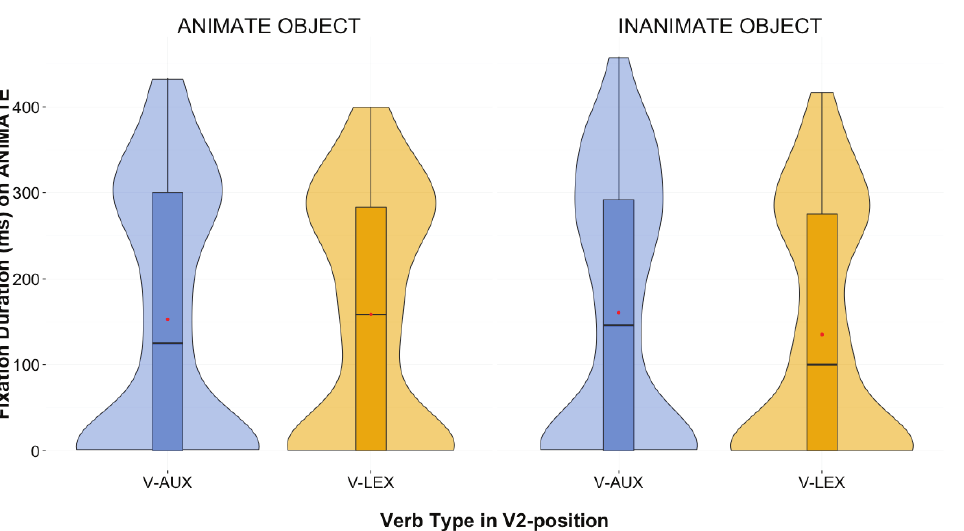
Figure 8: Violin/boxplot of fixation duration to the animate referent per condition in the early object integration window. The red dot encodes the mean, the black vertical line encodes the median, the top and bottom edges of the box encode the interquartile range and the transparent beans provide a density plot. Note that the statistical analysis was performed on the logit-transformed odds ratio of fixations to the animate referent over those to the inanimate